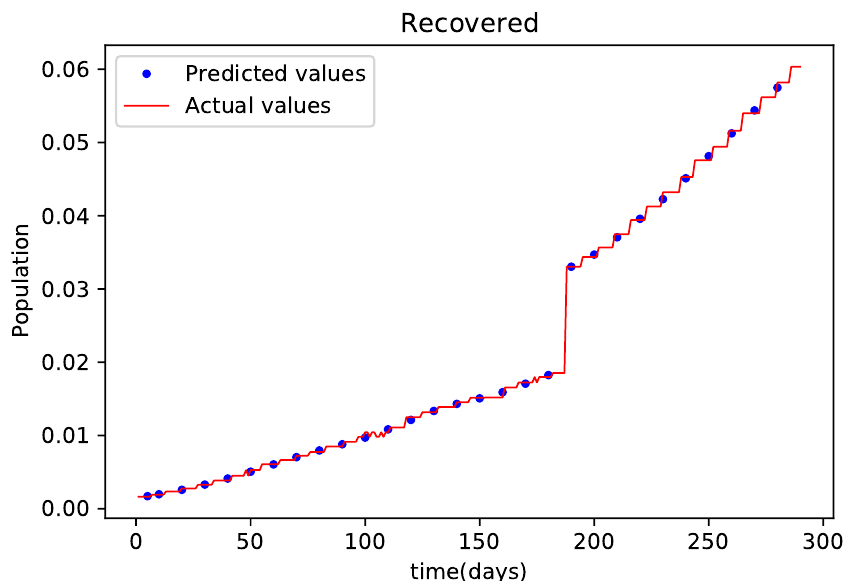
Figure 9. This graph shows a comparison of the predicted values of recovered population and the actual data of recovered population for the State of Alabama.